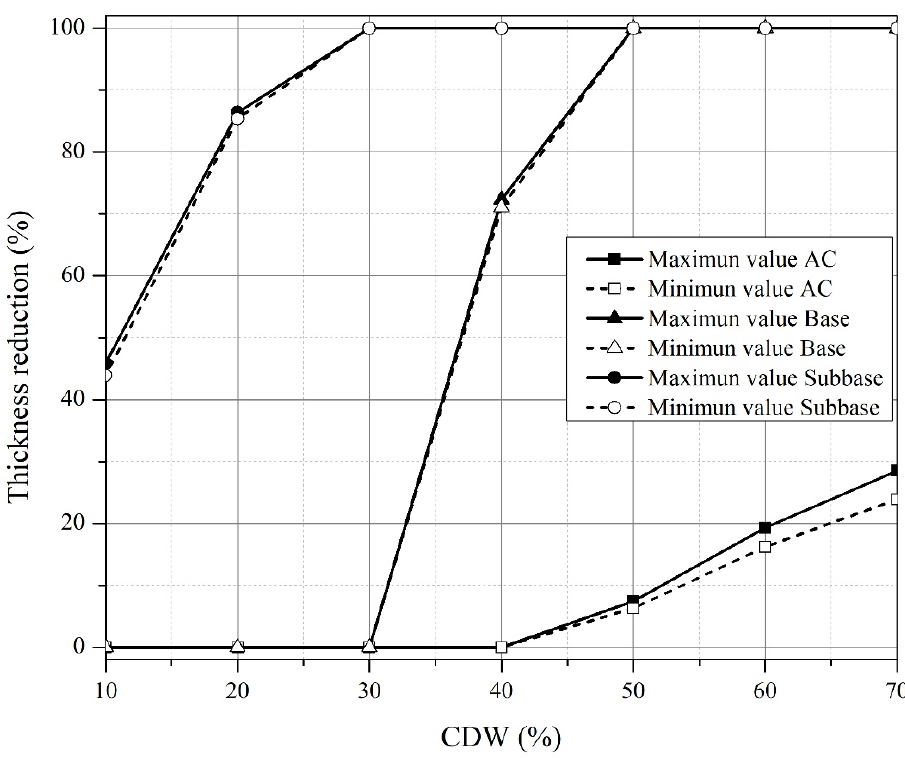
Figure 15. Percentage decrease in structural layer thickness by adding CDW to the subgrade.